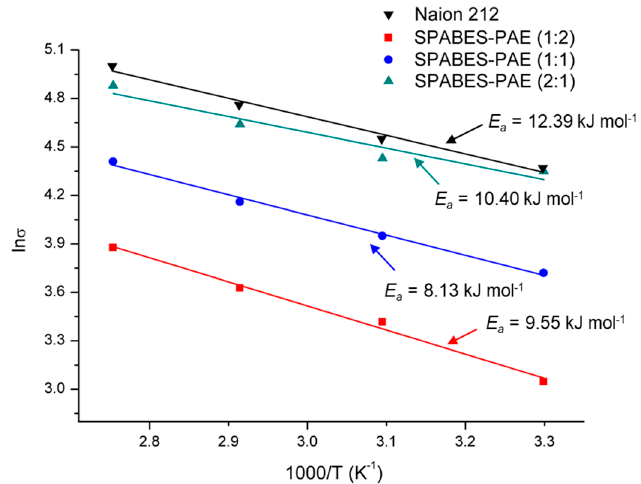
Figure 5. Arrhenius plot of membranes at various temperature and 100% RH.